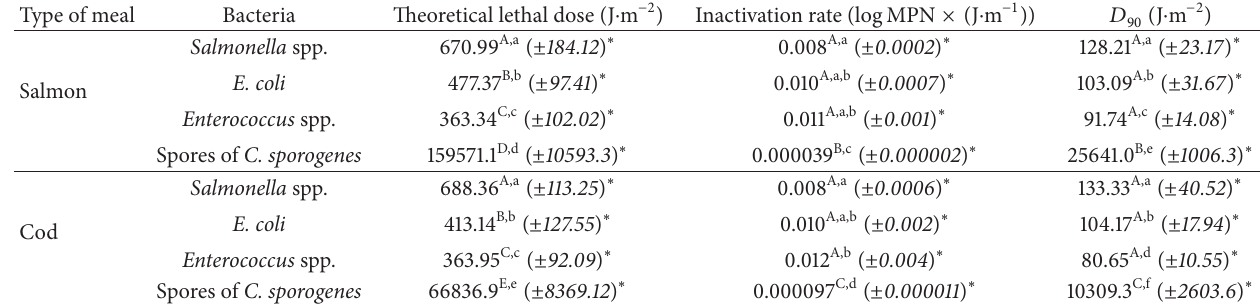
Table 6: Parameters describing inactivation kinetics of the studied bacteria in fish meal as affected by UV-C radiation. Type of